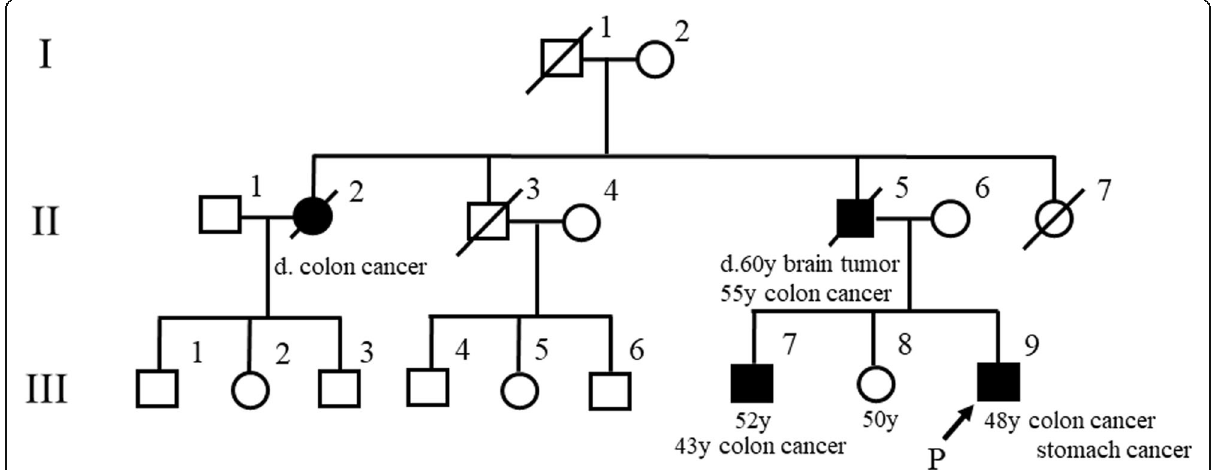
Fig. 1 Pedigree of this patient ’ s family. The arrow indicates the proband and filled symbol indicates person with colorectal cancer